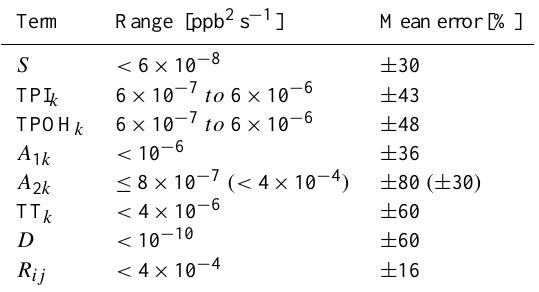
Table 3. Order of magnitude of terms of the balance equation of the covariance (Eq. 9) in ppb 2 s − 1 as explained in Sects. 5.2 and 5.3 for x k = z (vertical coordinate) and the mean error